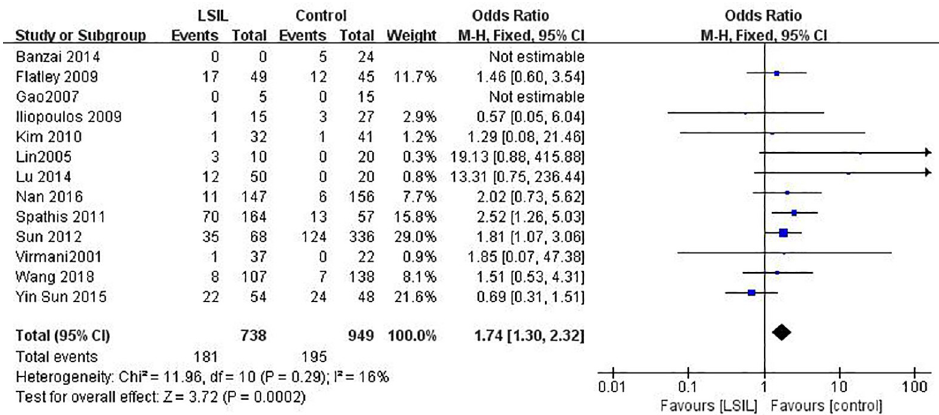
Fig 2. Funnel plots for associations of MGMT promoter hypermethylation with the risk of LSIL. The squares represent the ORs for individual studies. The size of the square reflects the weight of included studies. Bars represent the 95% confidence intervals (CIs). The center of the diamond represents the summary effect size. LSIL, low-grade intra-epithelial lesion. https://doi.org/10.1371/journal.pone.0222772.g002 compared with controls (the estimated required sample size of 13180 cases: Fig 9B), the cumu- lative Z-curve crossed the conventional boundary but not crossed the trial sequential monitor- ing boundary or required information size, which indicated that there still need more studies with large sample sizes in the future.